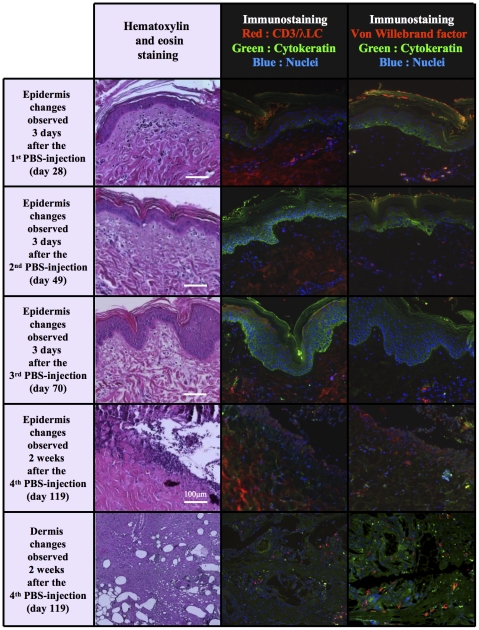
Epidermal and dermal radio-induced injuries in the skin of PBS-treated minipigs.Kinetic study from four iterative biopsies performed few days after each PBS-treatment in representative controls (magnification ×100). Progressive disorganisation of the epidermal layers, keratinocytes degeneration, vacuolation and barrier disruption. Numerous dermal cavities two weeks after the 4th PBS-treatment.